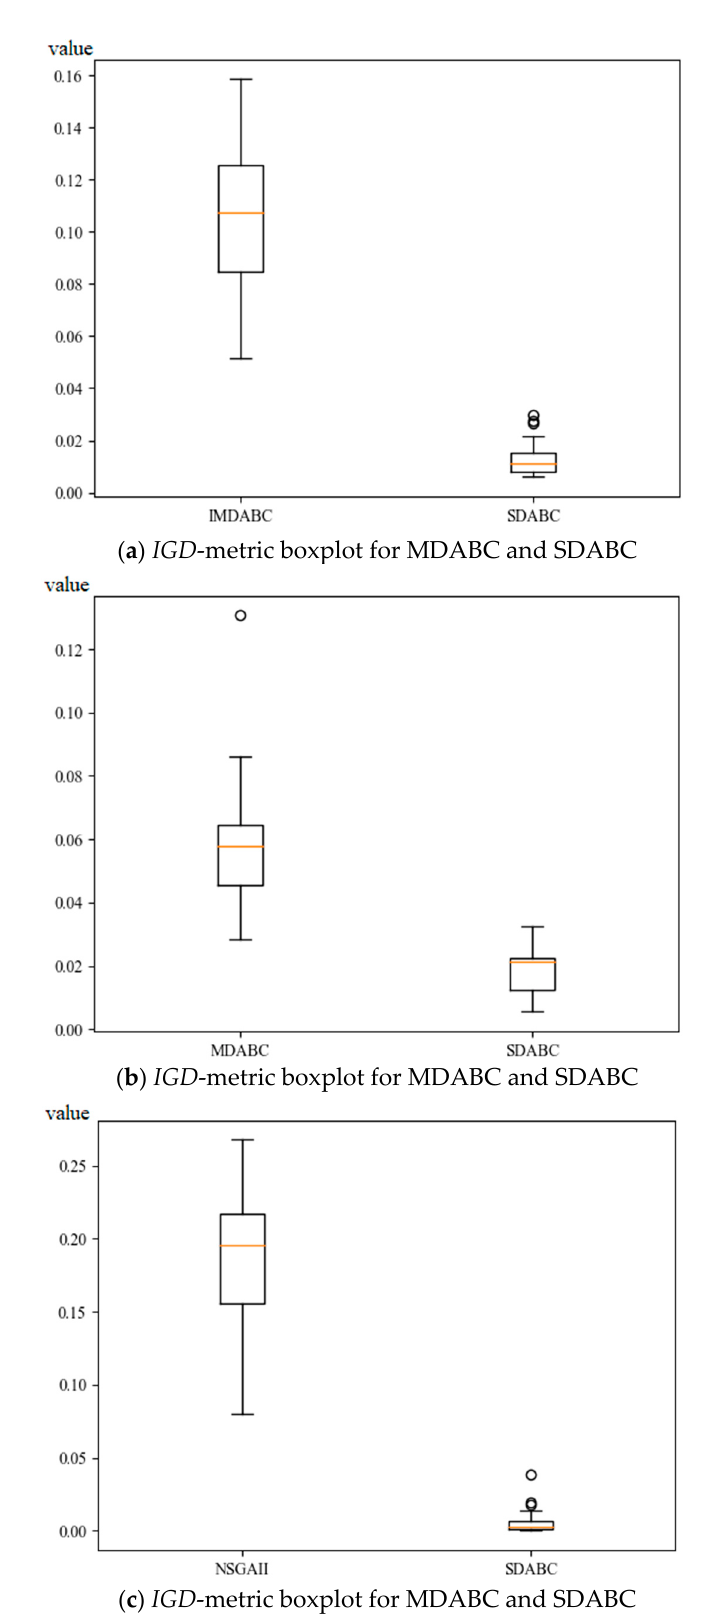
Figure 7. IGD -metric boxplot for NSGAII, IMDABC, MDABC, and SDABC.